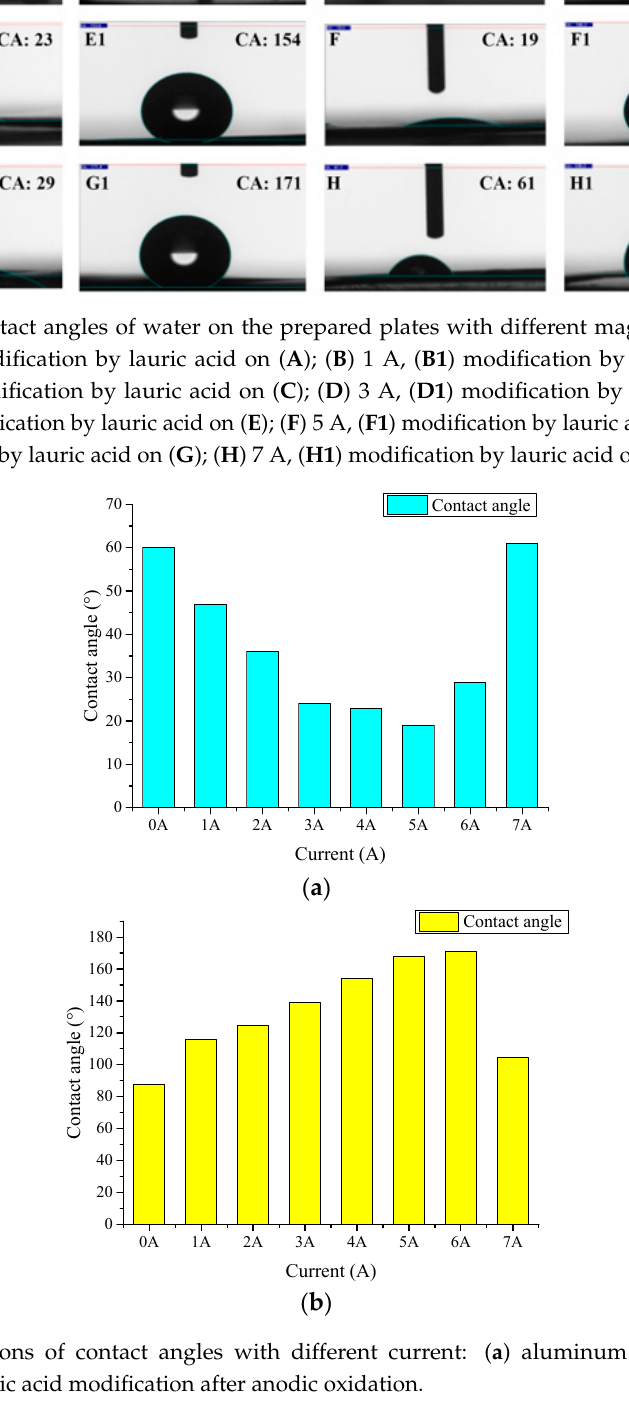
Figure 3. Variations of contact angles with different current: ( a ) aluminum anodic oxidation; ( b ) aluminum lauric acid modification after anodic oxidation.